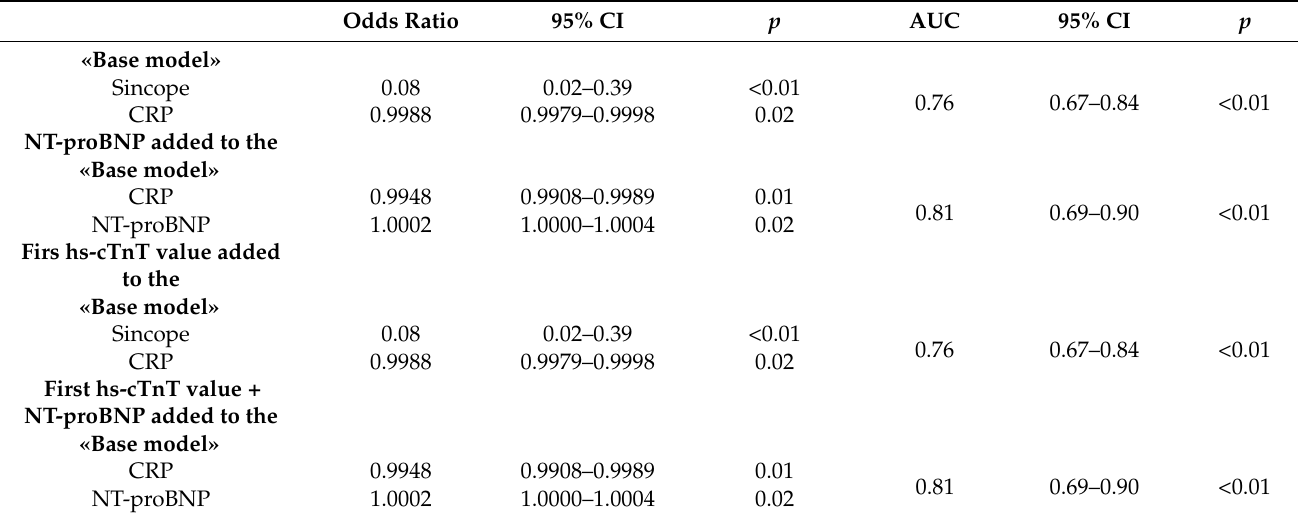
Table 3. Multivariable models—cardiovascular versus non-cardiovascular disease.